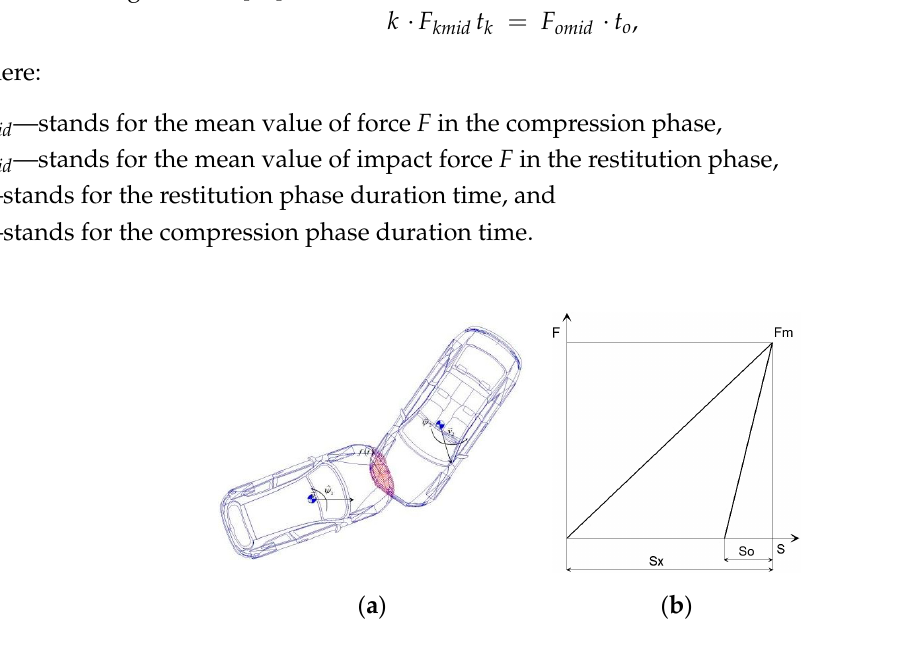
Figure 5. Impact area of vehicles ( a , b ) impact force F in the compression and restitution phase: S k —deformation depth in the compression phase, S o —depth of the elastic disappearing deformation in the restitution phase, and F m —maximum force value.